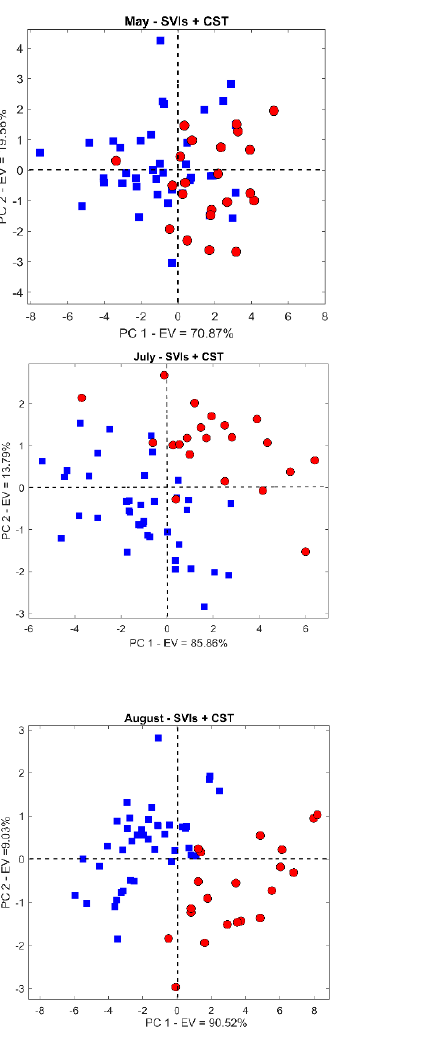
Figure 7. Cluster plots based on the first two principal components (PCs), blue squares and red circles represent healthy and infested plots, respectively. ( A ) Cluster plots based on all spectral indices VIP > 1 including CST, and ( B ) cluster plots based on all spectral indices VIP > 1 excluding CST. Table 5. Assessment of the generated map using reference data obtained from aerial photography.